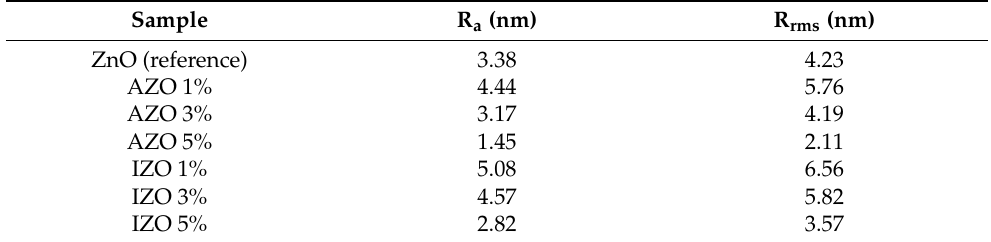
Table 2. Average and root mean square (rms) values of surface roughness measured using